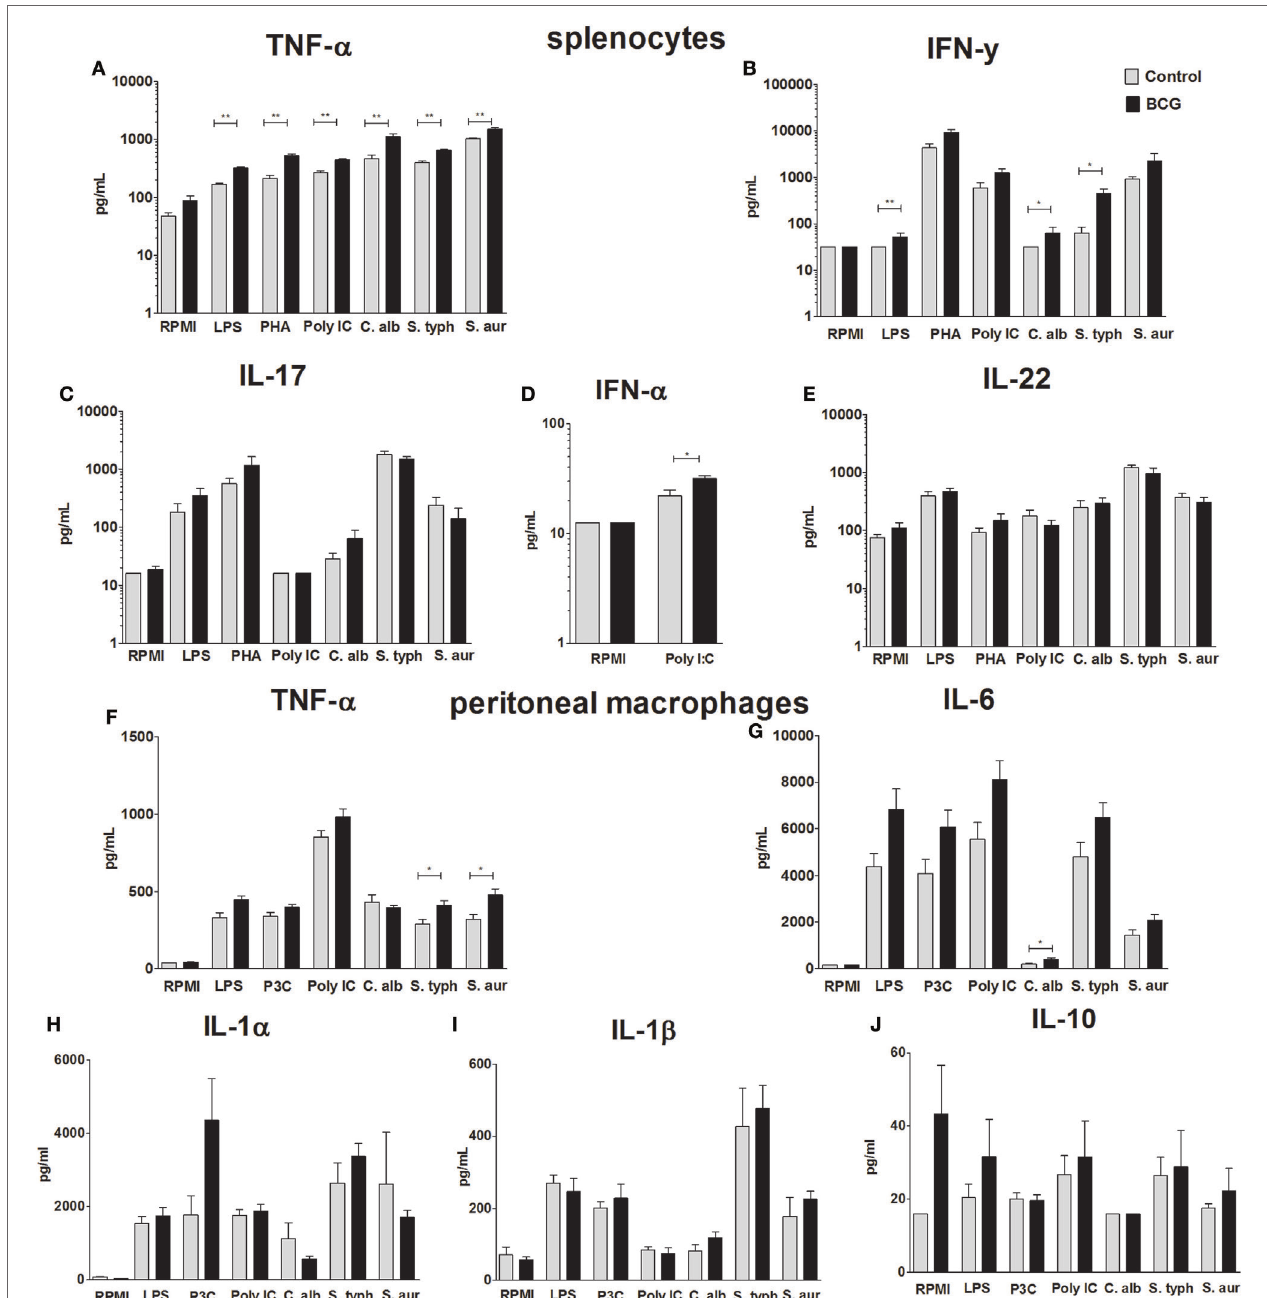
FigUre 3 | Bacillus Calmette–Guérin (BCG)-induced trained immunity cytokine responses. To demonstrate increased innate immune response after BCG vaccination, spleen cells and peritoneal macrophages were isolated 7 days after administration of either BCG or phosphate buffered saline. Concentrations of tumor necrosis factor-alpha (TNF- α ), interferon (IFN)- α , IFN- γ , interleukin (IL)-17, and IL-22 determined by enzyme-linked immunosorbent assay (ELISA) in supernatants of restimulated splenocytes with Roswell Park Memorial Institute (RPMI), lipopolysaccharide (LPS), phytohemagglutin (PHA), poly I:C, Candida albicans , Salmonella typhi , and Staphylococcus aureus are shown (a–e) . Concentrations of IL-1 α , IL-1 β , IL-6, IL-10, and TNF- α determined by ELISA in supernatants of restimulated peritoneal macrophages with RPMI, LPS, poly I:C, C. albicans , S. typhi , and S. aureus are shown (F–J) . Data are shown as mean ± SEM, n = 5 per group, * p < 0.05, ** p < 0.01 Mann–Whitney U (two-sided).